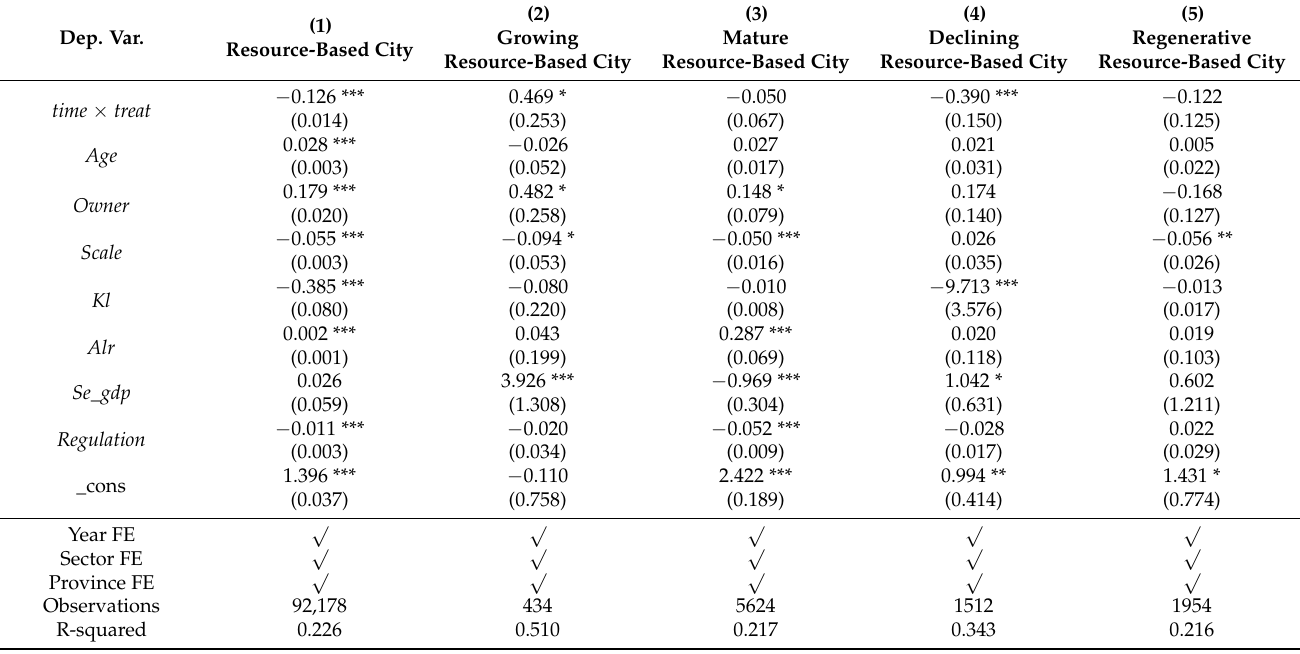
Table 15. Regional heterogeneity